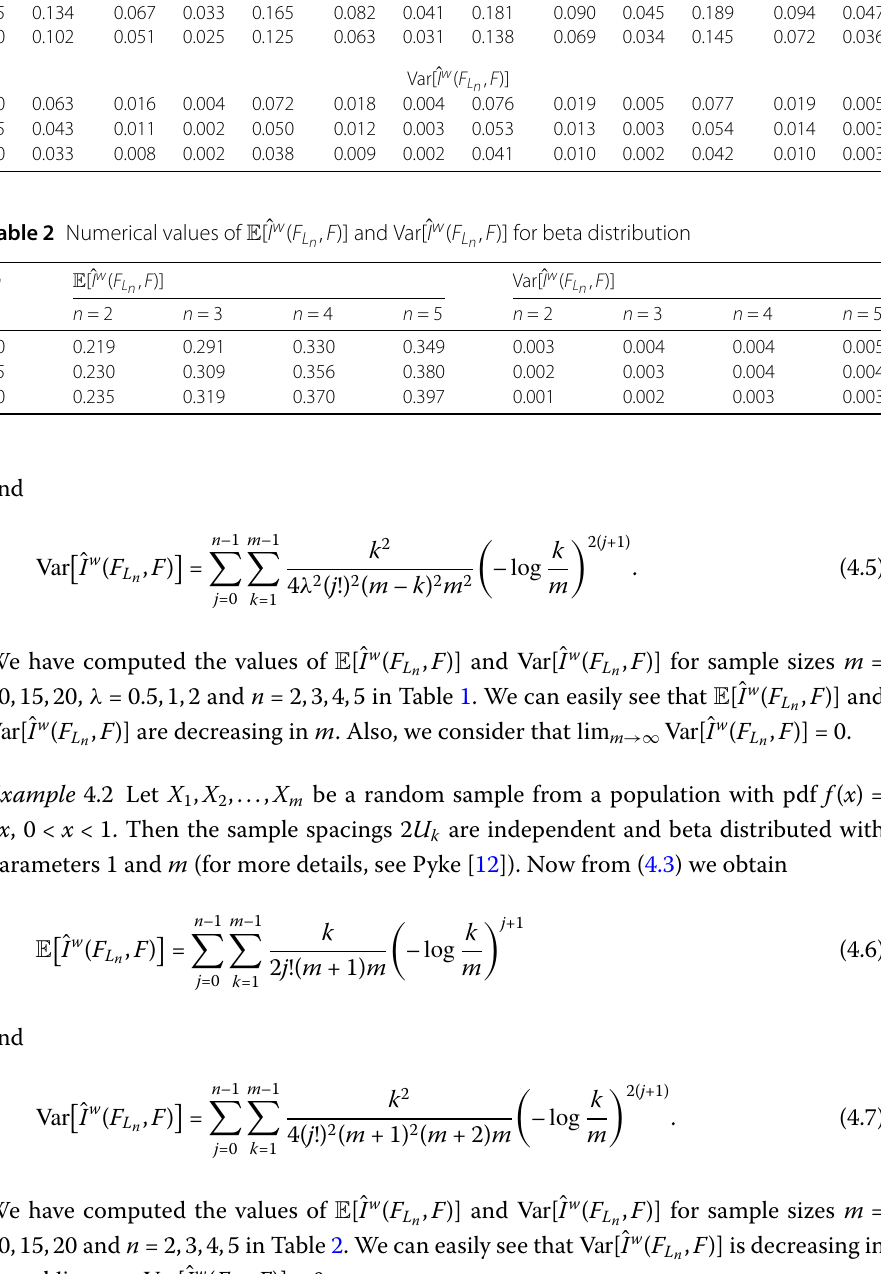
Table 1 Numerical values of E [ ˆ I w ( F L m